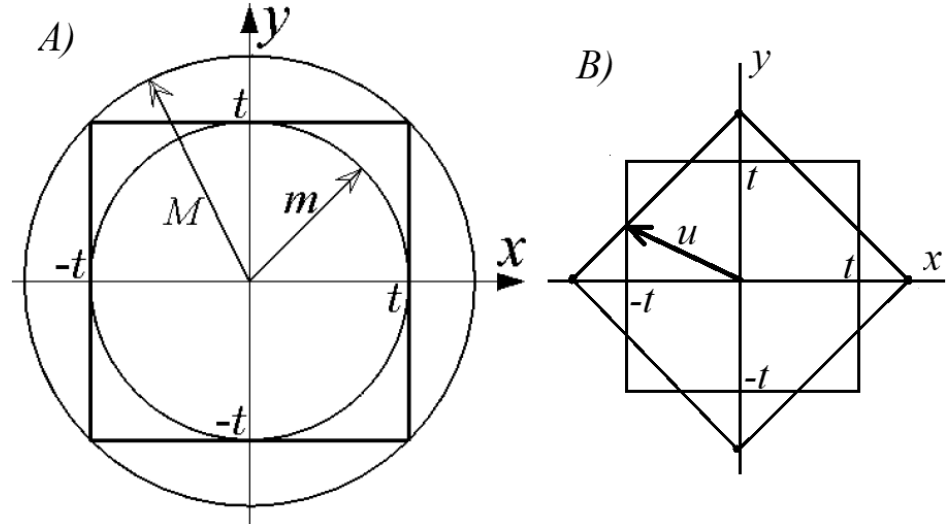
Figure 1. ( A ) As the integrant is positive, the value of the integral over the interior of the square lies between the values of integrals over the interiors of the circumferences of radii m and M . ( B ) The previous integration square is taken and rotated by π /4 and put together with the exact copy of the square. The integral over the common inner area is denoted by ω